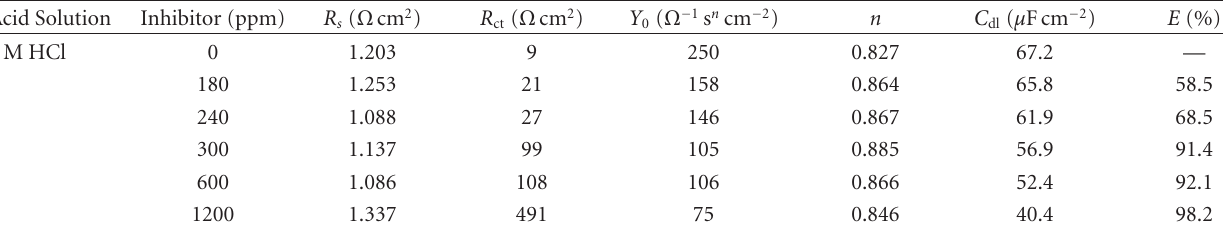
Table 3: Electrochemical impedance parameters for mild steel in 1M HCl in absence and presence of di ff erent concentrations of Kalmegh (Andrographis paniculata) extract.